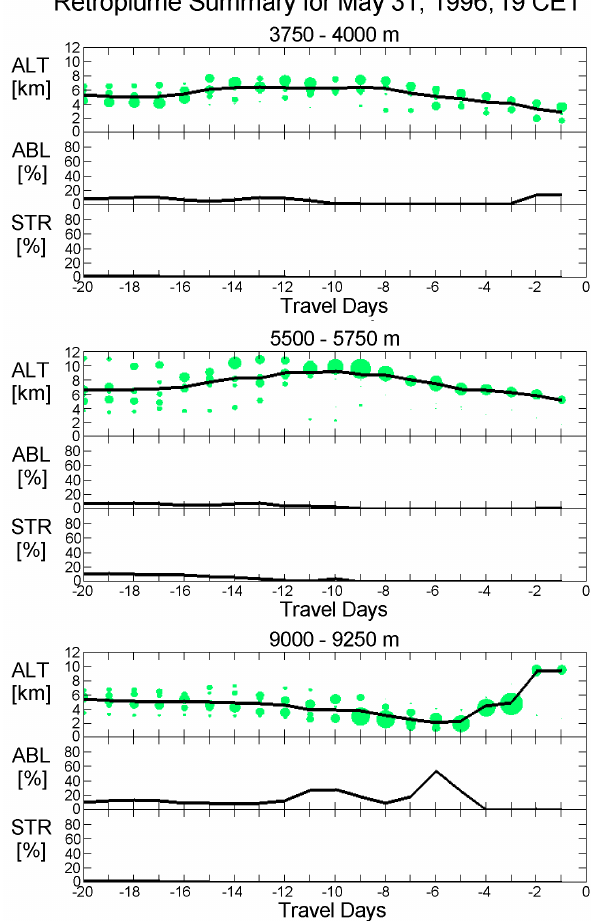
Fig. 5. Retroplume summaries from the twenty-day simulation for three selected altitude ranges above Garmisch-Partenkirchen initi- ated at the time of the lidar measurement in Fig. 1. The panels show the approximate vertical position (ALT: altitude) of the back- ward plume during the preceding 20days and the relative single-day contributions from the PBL (ABL) and the stratosphere (STR). The diameter of the green circles represents the number of particles in a given cluster for the respective days. For more details see Sect.